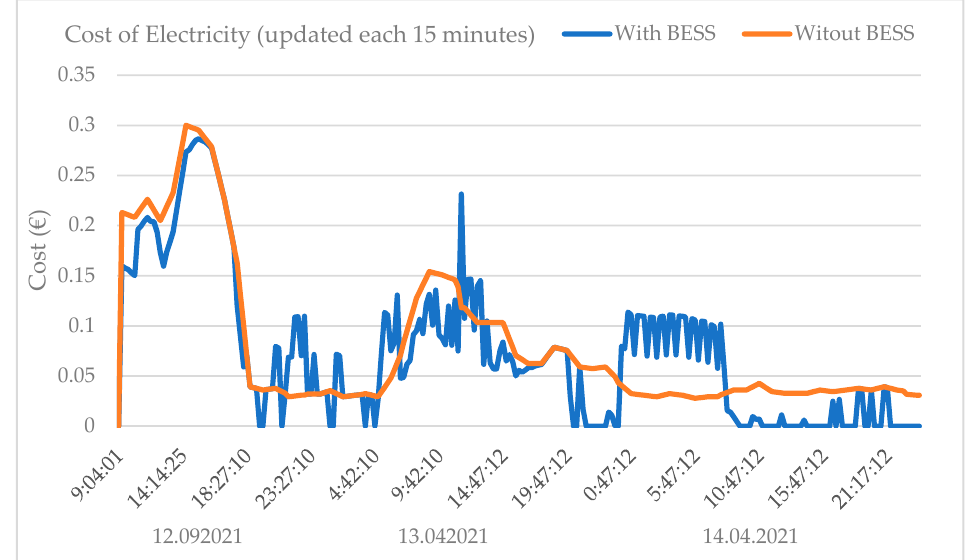
Figure 10. Cost of imported electricity at 15 min granularity. The cost of imported electricity with and without BESS is shown. The cost with BESS is higher than the cost without BESS when the BESS charges the battery and lower when discharges the battery.